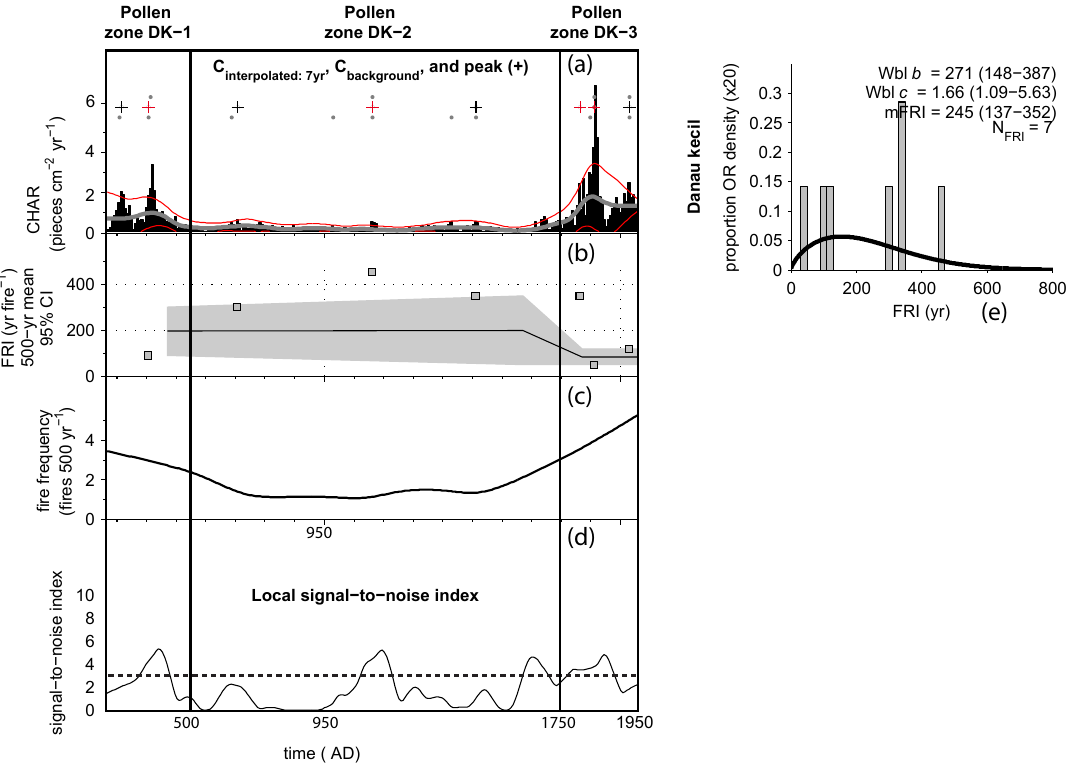
Figure 5. The reconstructed fire regime from the DK core was obtained by CharAnalysis (Higuera et al., 2009). ( a ) Raw charcoal counts were interpolated to 7 yr intervals (C interpolated ); reconstructed fire episode inferred fire frequency (fires 500 yr window) with a total of eight fire peaks (black crosses). ( b ) Corresponding fire frequency (500 yr window). ( c ) Corresponding mean fire frequency (500 yr window). ( d ) Local signal-noise index (SNI). ( e ) The mean fire return interval (mFRI) was 245